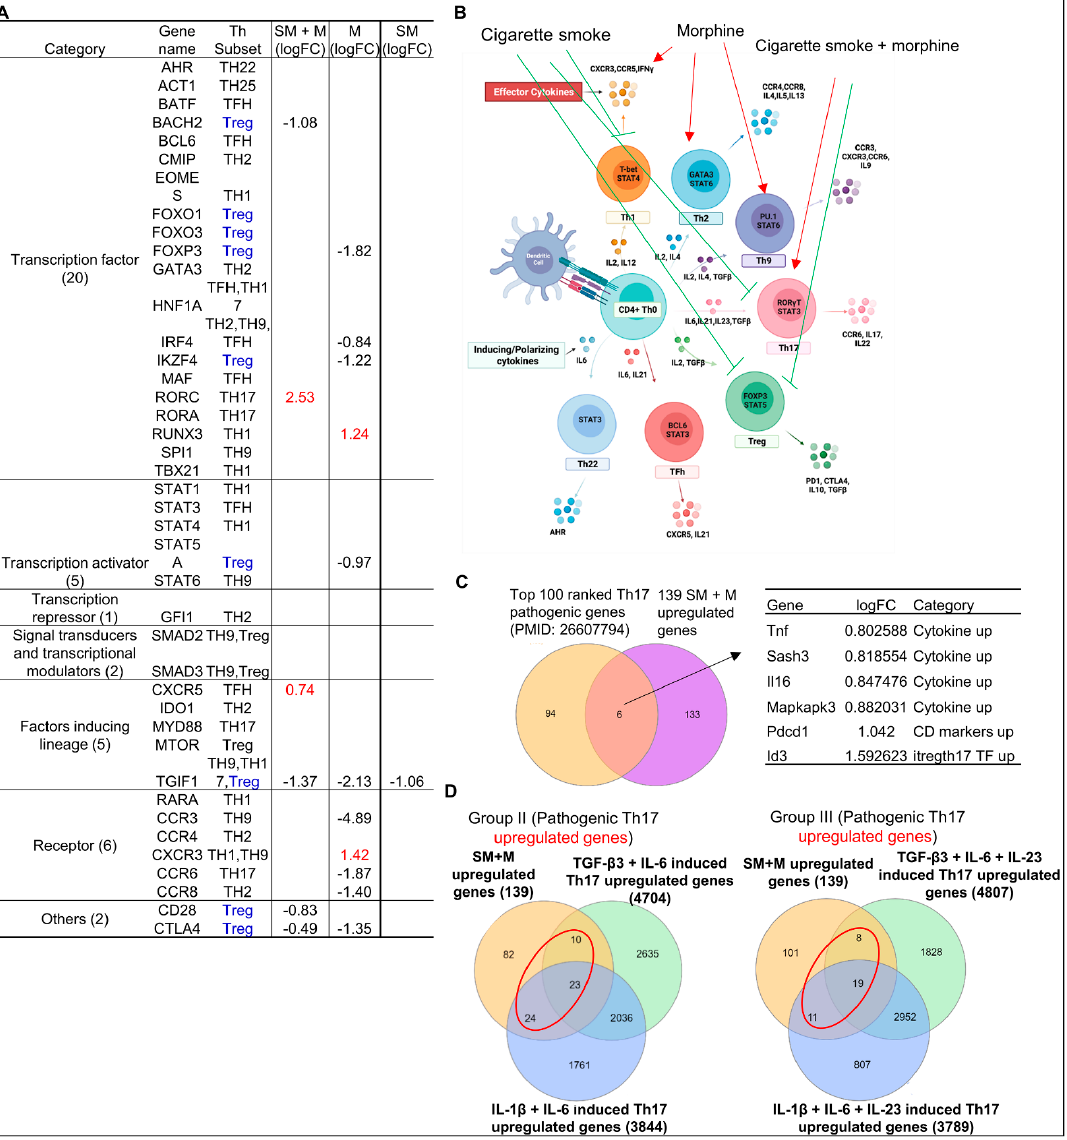
Figure 6. Cigarette smoke plus morphine promoted Th17 genes and suppressed Treg genes. ( A ) SM + M, M, and SM modulated the expressions of 6, 11, and 1 out of 41 regulators of seven CD4 + T helper cell (Th) subsets (Th1, Th2, Th9, Th17, Treg, follicular Th (Tfh), and Th22) respectively, which include seven groups such as transcription factors (20), transcription activators (5), transcription repressor (1), signal transducers and transcription modulators (2), factors inducing lineage (5), re- ceptors (6), and others (2). SM + M upregulated Th17 transcription factor RORC and CXCR5 (red); M upregulated transcription factor RUNX3, Th1-Th9 receptor CXCR3; and SM alone did not upreg- ulate any genes but downregulated Treg TGIF1. ( B ) Schematic figure shows CD4 + T helper (Th) subset regulators. SM + M promoted Th17 (red arrow) and inhibited Treg (green blockers). M pro- moted Th1, Th2, and Th9 (red arrow). However, SM inhibited Th1, Th17, and Treg (green blockers). ( C ) The Venn diagram analysis showed that six genes including four cytokines and interaction pro- teins including TNF, SASH3, IL-16, MAPKAPK3, one CD marker PDCD1, and one Th17-iTreg